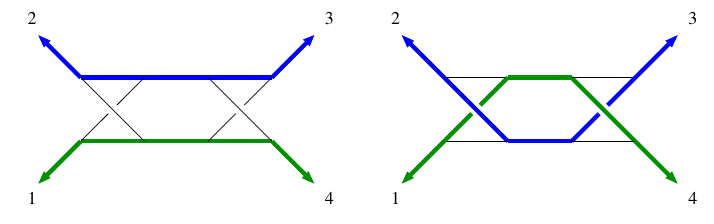
Figure 4 . Two possible momentum routings for I ( d )